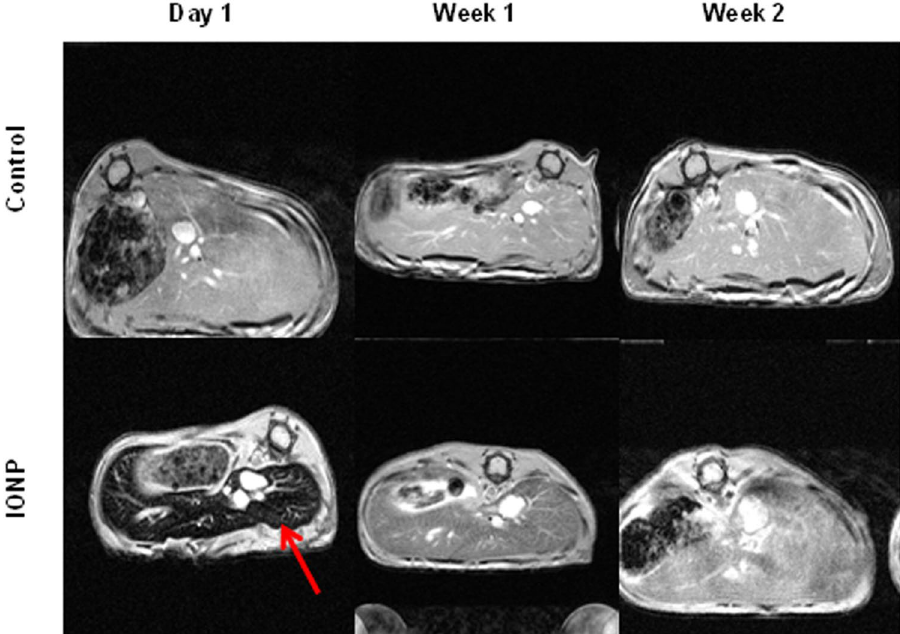
Figure 7. In vivo T 2 * - weighted MR imaging showed axial views of mice liver area up to 2 wk after injection, with an area of hypointensity due to the IONP indicated by the arrow. Selected MRI images are representative of three mice that received IONP-DHCA nanoparticles or just PBS